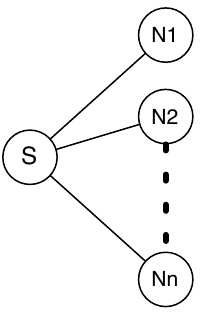
, ..., N are neighbors of each other. 1 n